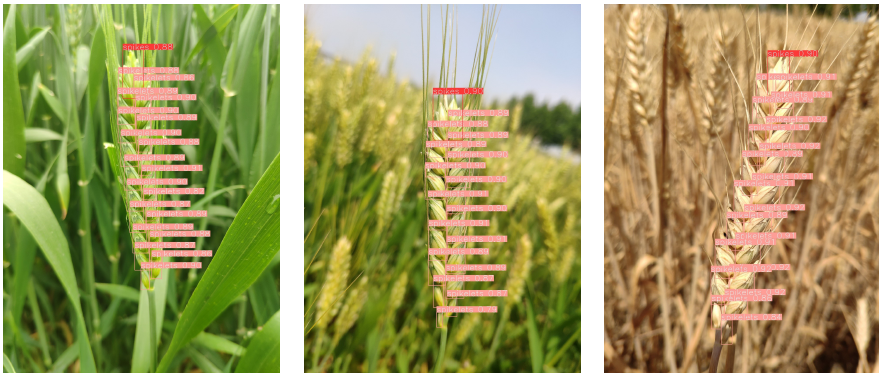
Figure 8. The detection results on different fertility stages by YOLOv5s-T(EIoU).